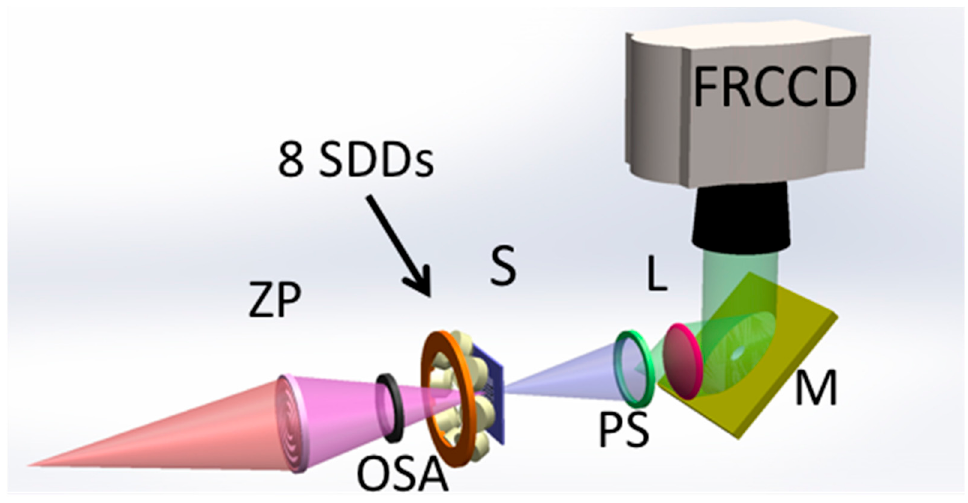
Figure 1. Schematic view of the TwinMic STXM mode setup with the microprobe forming zone plate (ZP) on the specimen (S), diffraction order-selecting aperture (OSA), transmission detection system with fast-read-out CCD camera (FRCCD) and visible light converting system (VLCS), and low-energy X-ray fluorescence (LEXRF) detector system based on 8 silicon drift detectors (SDDs) in backscattered configuration. The VLCS consists of a phosphor screen (PS), a lens (L) and a 45°-tilted mirror (M).